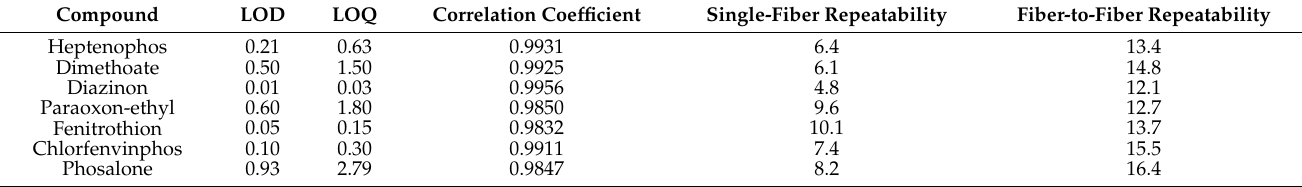
Table 2. Analytical characteristics of the developed HS-SPME-GC-FID method for organophosphorus insecticide determination using the investigated silica-IL